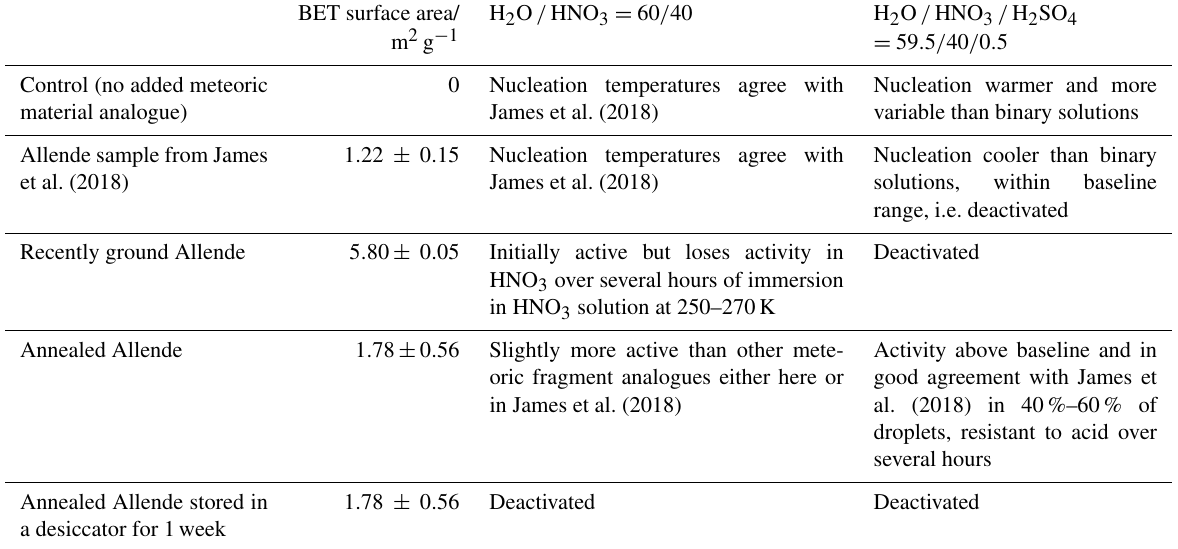
Table 1. Summary of samples prepared (see Sect. 2) and observed heterogeneous